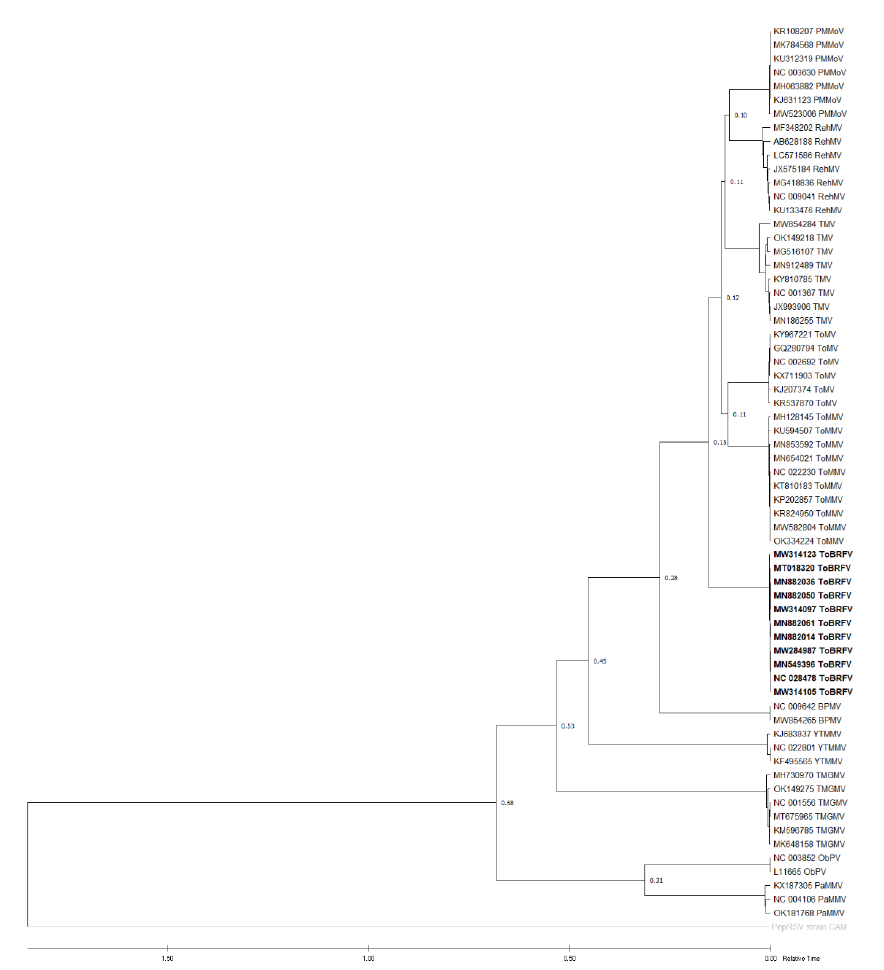
Figure 4. Divergence time estimation of 11 tobamoviruses with Asterids as main hosts: pepper mild mottle virus (PMMoV), rehmannia mosaic virus (RheMV), tobacco mosaic virus (TMV), tomato mosaic virus (ToMV), tomato mottle mosaic virus (ToMMV), tomato brown rugose fruit virus (ToBRFV), bell pepper mottle virus (BPMV), yellow tailflower mild mottle virus (YTMMV), tobacco mild green mosaic virus (TMGMV), obuda pepper virus (ObPV), and paprika mild mottle virus (PaMMV) by RelTime-ML in MEGA X. An isolate of pepper ringspot virus (PepRSV, genus Tobravirus ) was used as out-group. Table 5. Estimated ToBRFV TMRCA based on the ratio of the patristic distances within the ten Table 4. Identity percentage of the complete genome nucleotide and amino acid sequences of To- Asterids-infecting tobamoviruses’ complete genome sequence maximum likelihood tree. BRFV with other Asterids-infecting tobamoviruses. Identity (%) Species Mean Patristic Distance Ratios of ToBRFV and Other Patristic Distances ToBRFV vs. Nucleotide Amino Acid PaMMV 0.68 4.53 PMMoV ObPV